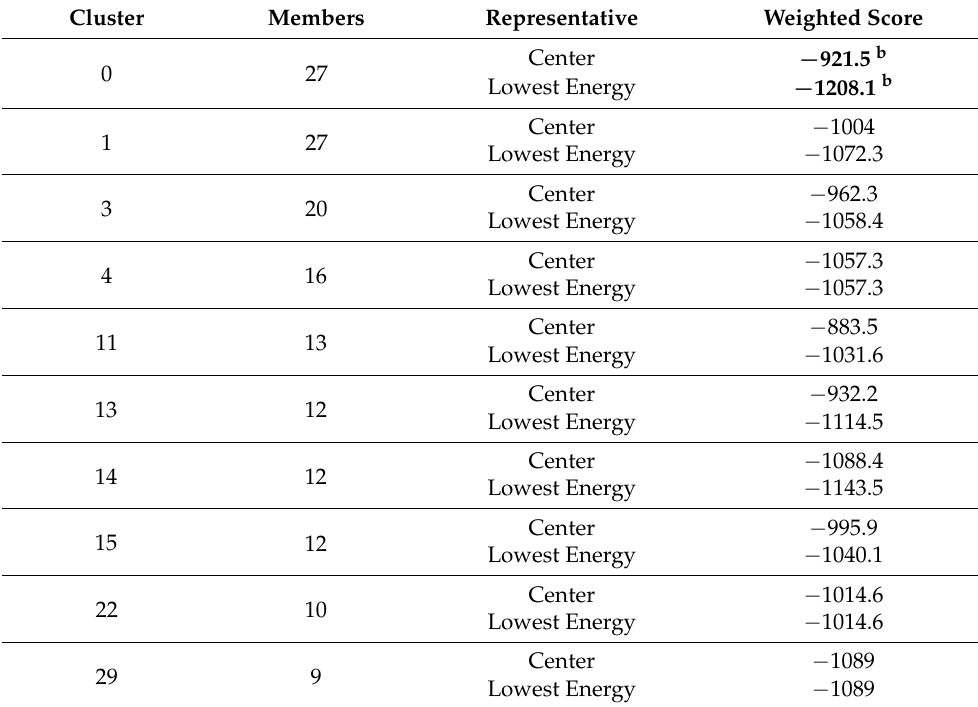
Table 4. Prediction results of docking of S7D5L4 with TLR4 molecules a